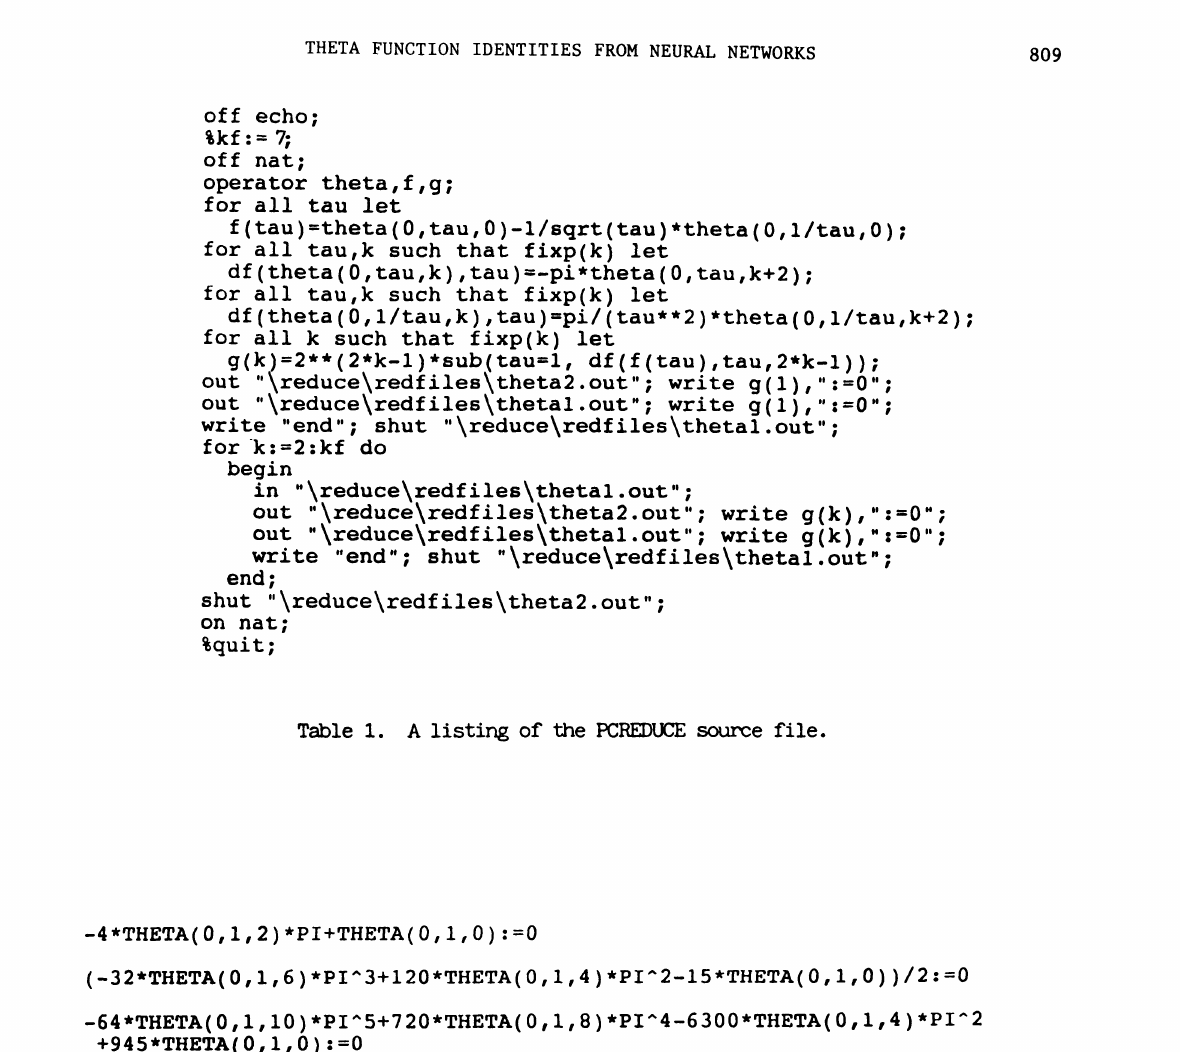
Table i. A listing of the PCREDUCE source file.